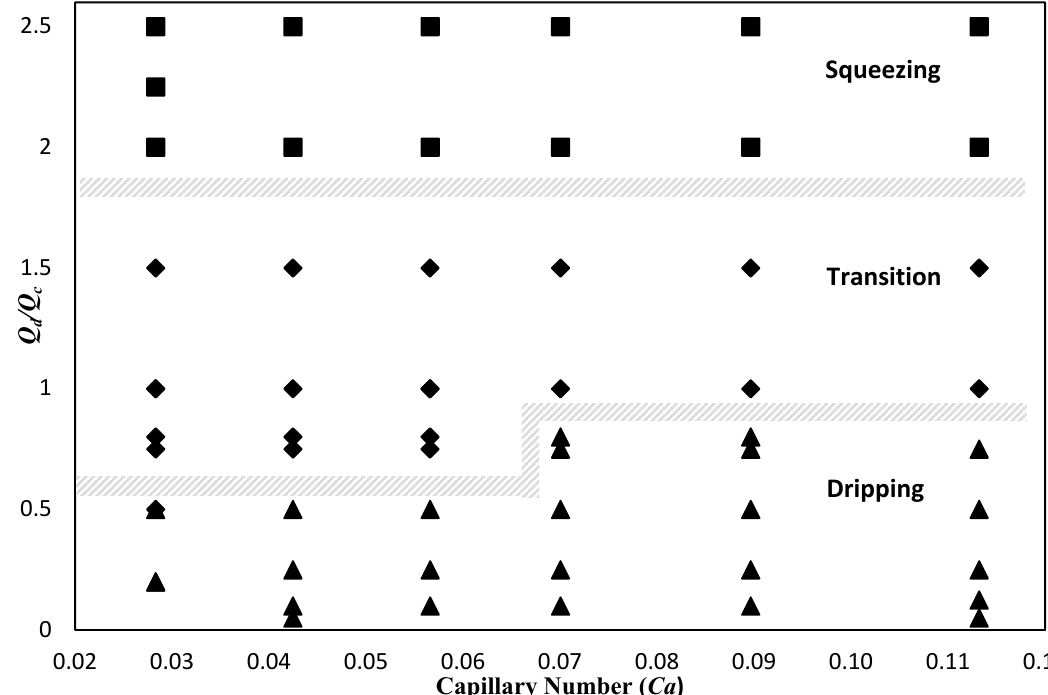
Figure 3. Flow regime map at constant capillary numbers where triangles correspond to dripping, diamonds to transition, and rectangles to squeezing. Shaded regions on the graph indicate the postulated transition between regimes.